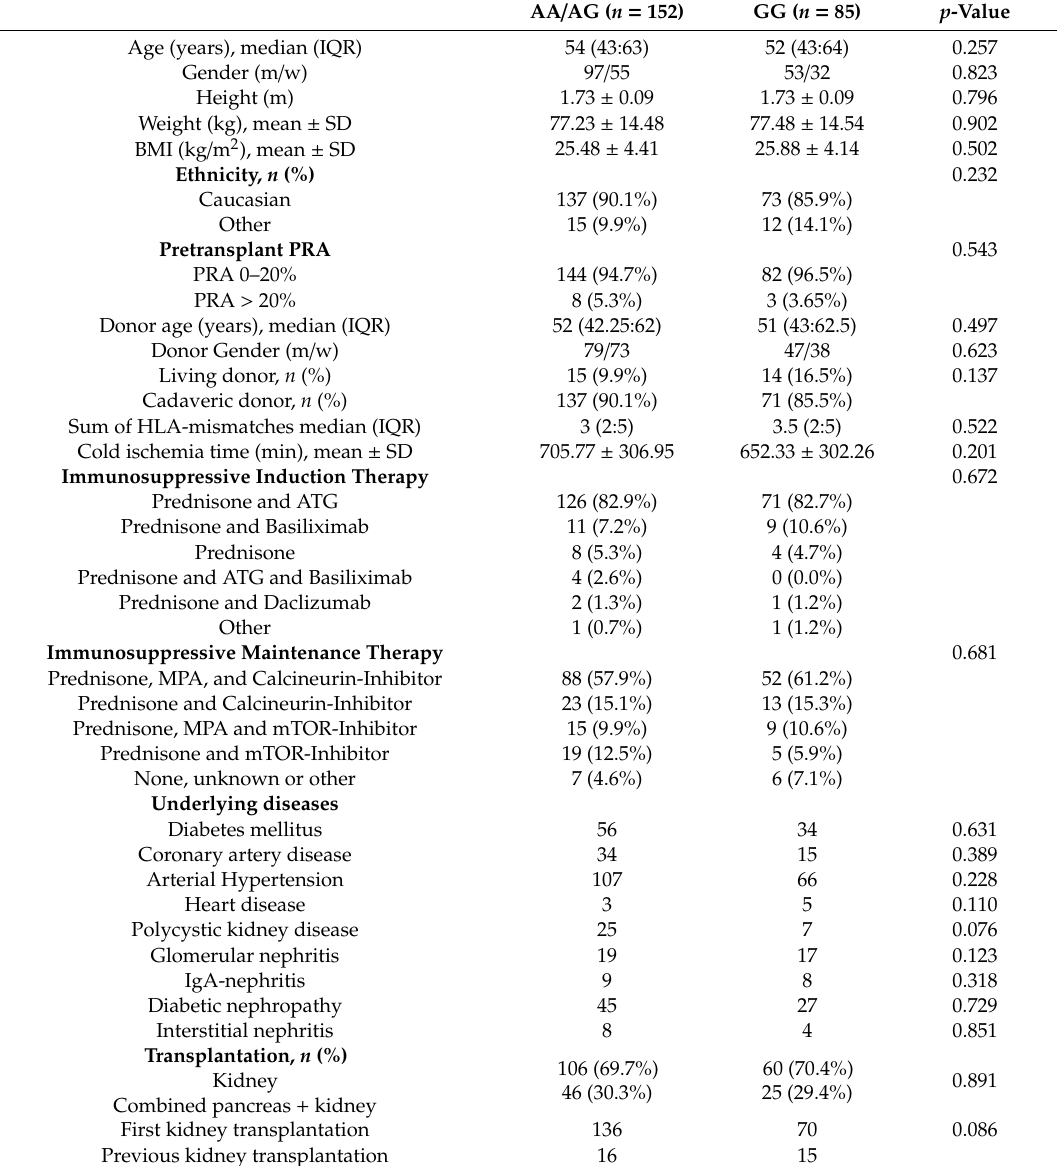
Table 1. Characteristics of kidney transplant patients ( n = 237) at baseline stratified by the AQP3 A( − 1431)G